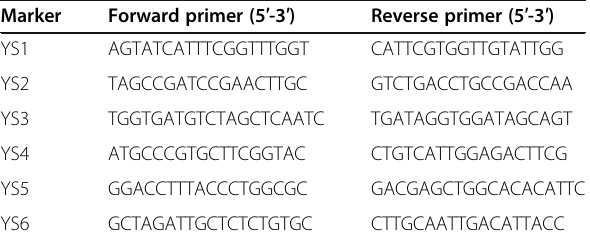
Table 1 Polymorphic InDel markers developed in this study Marker Forward primer (5 ′ -3 ′